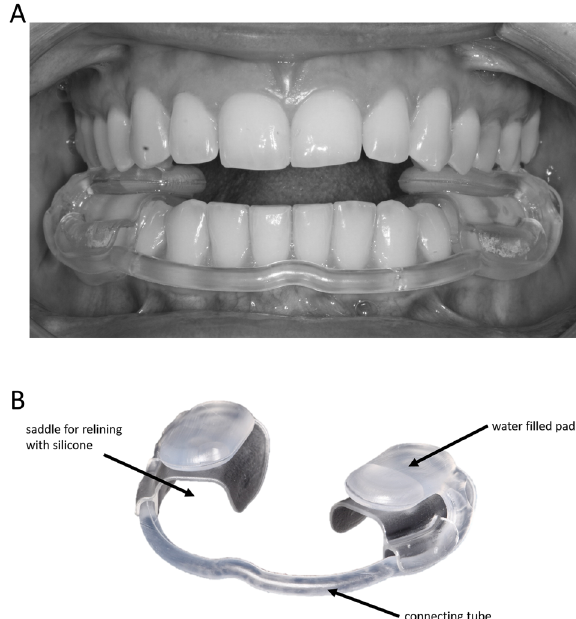
Fig. 1 Hydrostatic oral splint. A Clinically adjusted appliance. The dental arches are discluded by the water fi lled pads. B Design and components of the